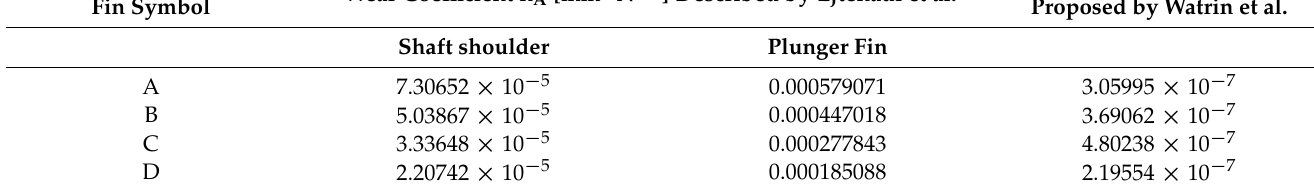
Table 16. The values of wear coefficient k A [mm 2 N − 1 ] described by Ejtehadi et al. [93], as cited in [94], and of the wear coefficient k A proposed by Watrin et al. [94] for the shaft shoulders and corresponding plunger fins.